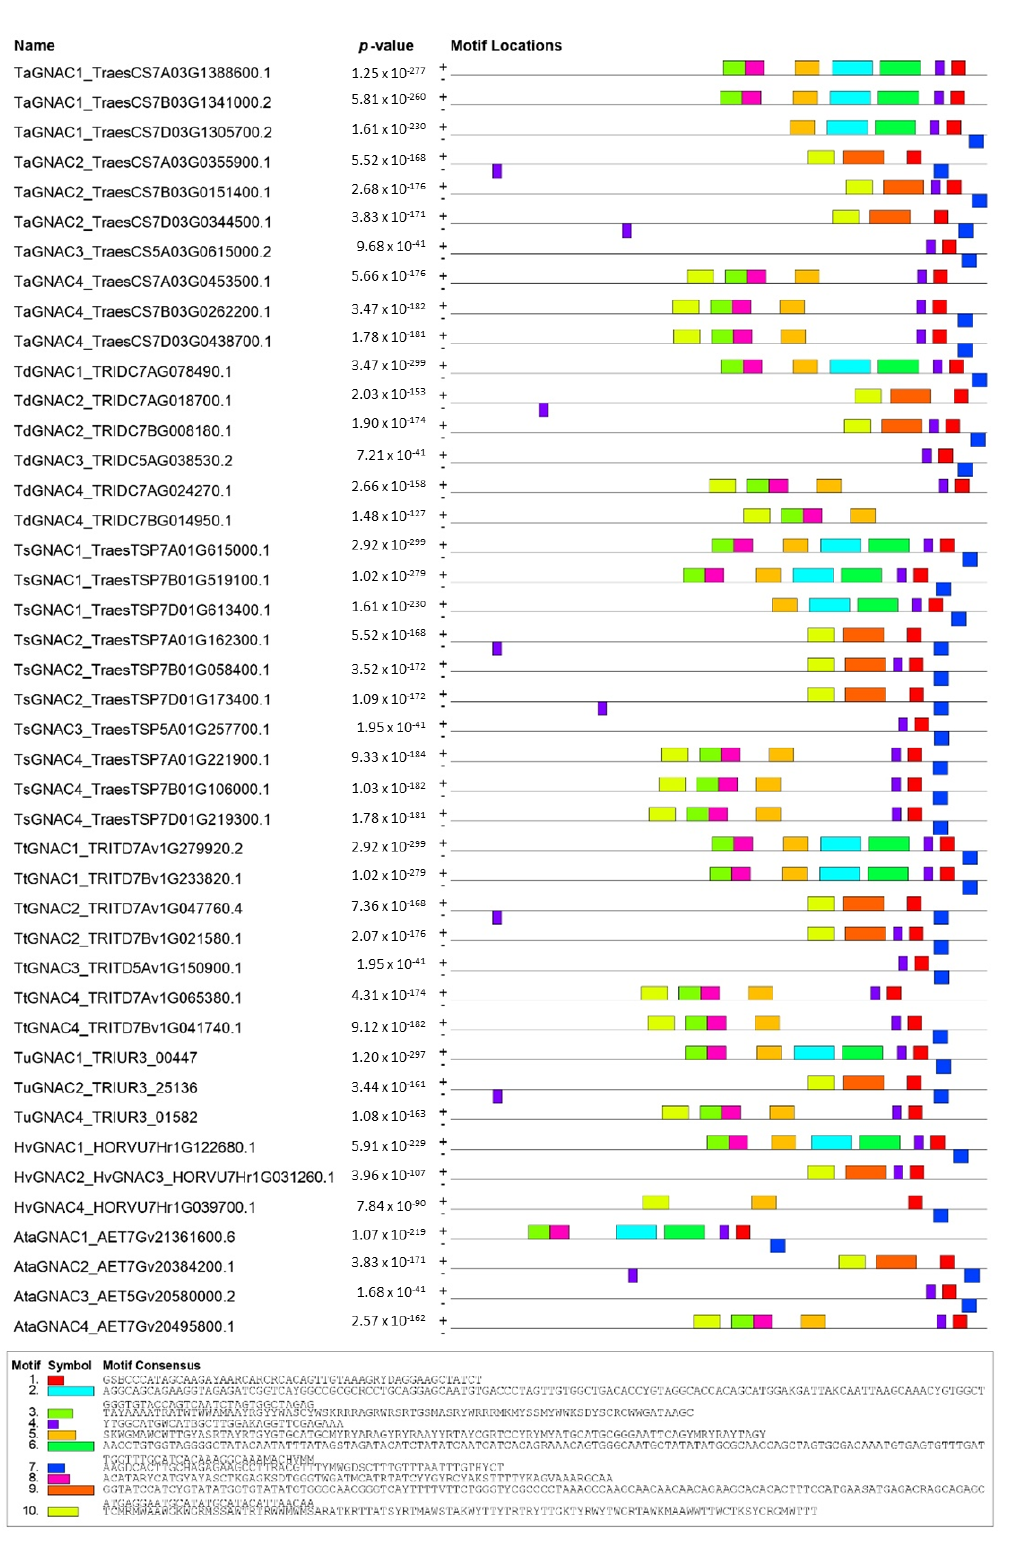
Figure 7. Identification of conserved motifs in the promoter (2000 bp upstream of the CDS) of the four bread wheat TaGNAC genes homeologs and their orthologs in 13 cereal species. Ata: Aegilops tauschii , Bd: Brachypodium distachyon , Hv: Hordeum vulgare , Os: Oryza sativa , Ph: Panicum hallii , Sb: Sorghum bicolor , Sin: Sesamum indicum , Sit: Setaria italica , Ta: Triticum aestivum , Td: Triticum dicoccoides , Ts: Triticum spelta , Tt: Triticum turgidum , Tu: Triticum urartu , Zm: Zea maya